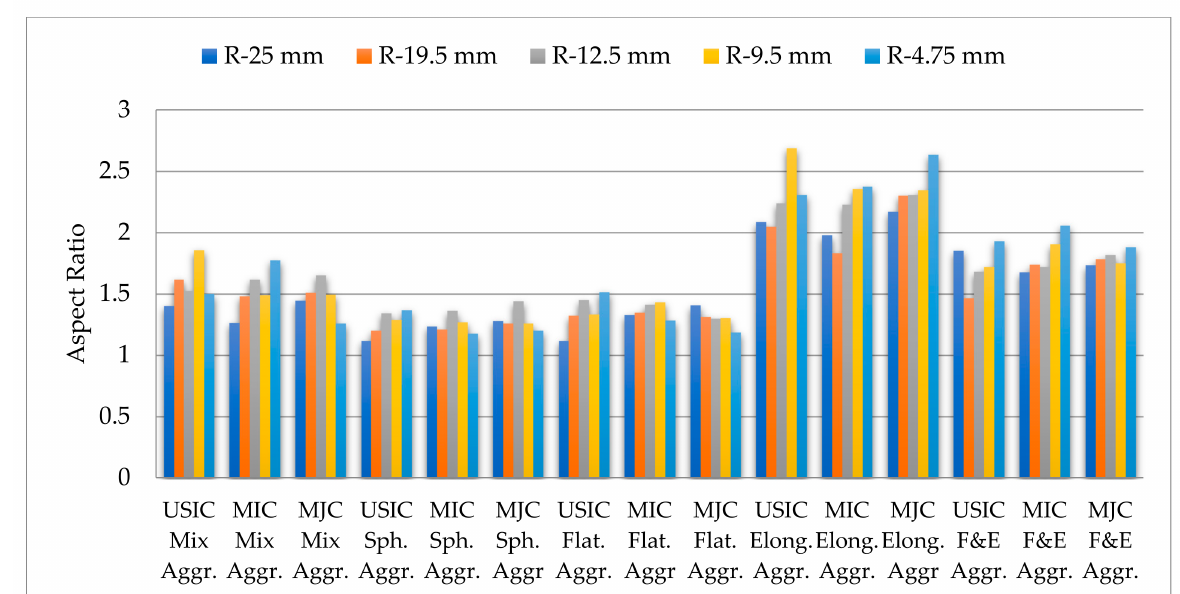
Figure 5. Aspect ratio of different aggregate shapes and types of crushers.